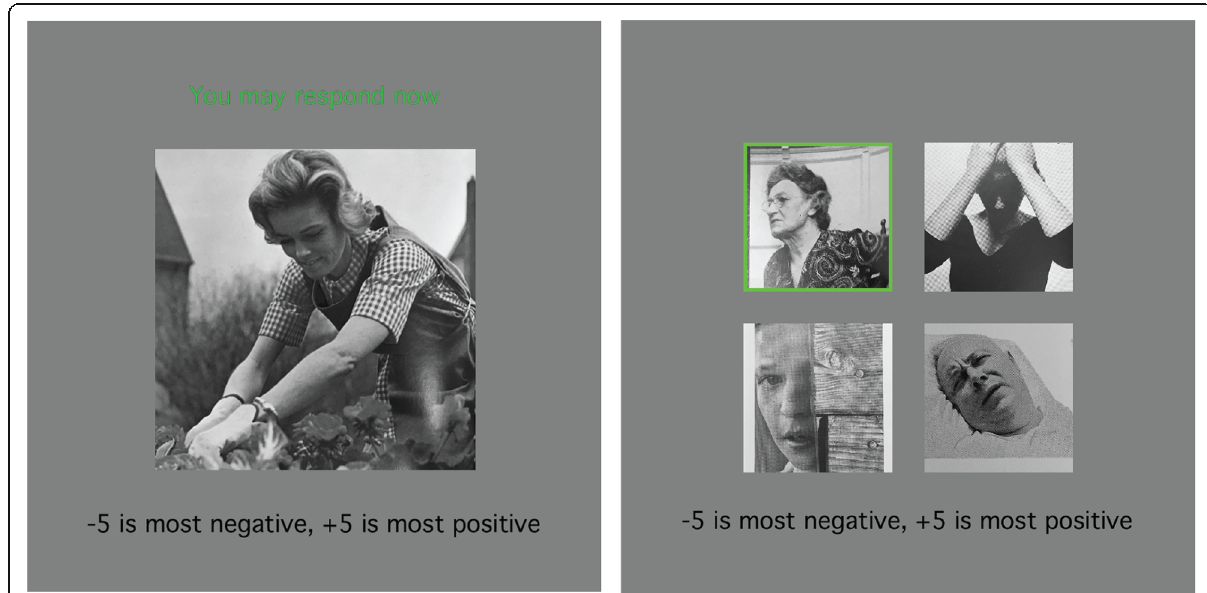
Fig. 1 Example trials from Part I ( left ) and II ( right ). Participants rated the emotional valence of a single image in Part I and then a cued image from a set of four in Part II